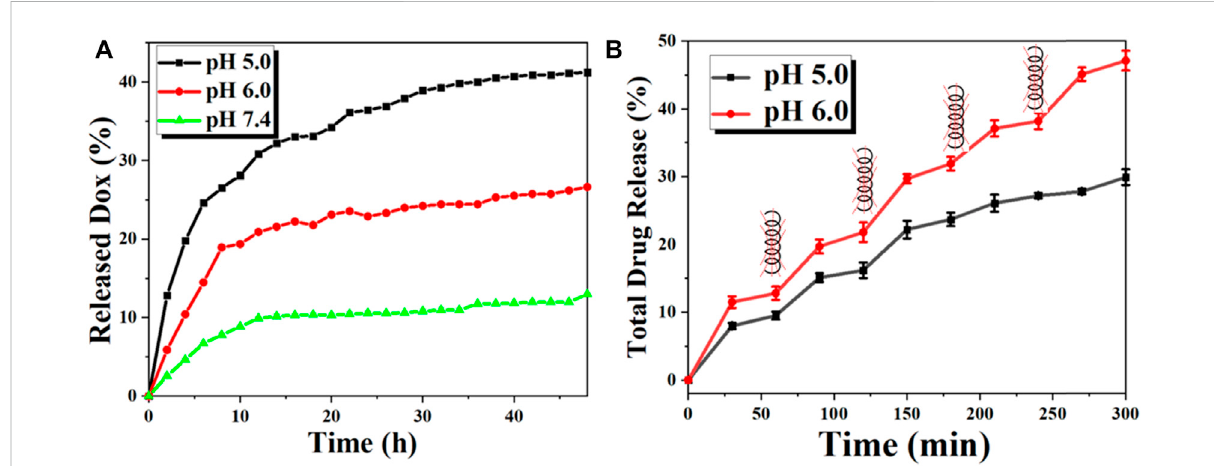
FIGURE 5 The in vitro DOX release behavior of theFVNH-DOX. (A) Cumulative DOX release pro fi les of FVNH-DOX at different pH within 2 days and (B) In the presence and absence of AMF with a 400 kHz 600 G at different time points (each time point lasts 10 min) under different pH within 5